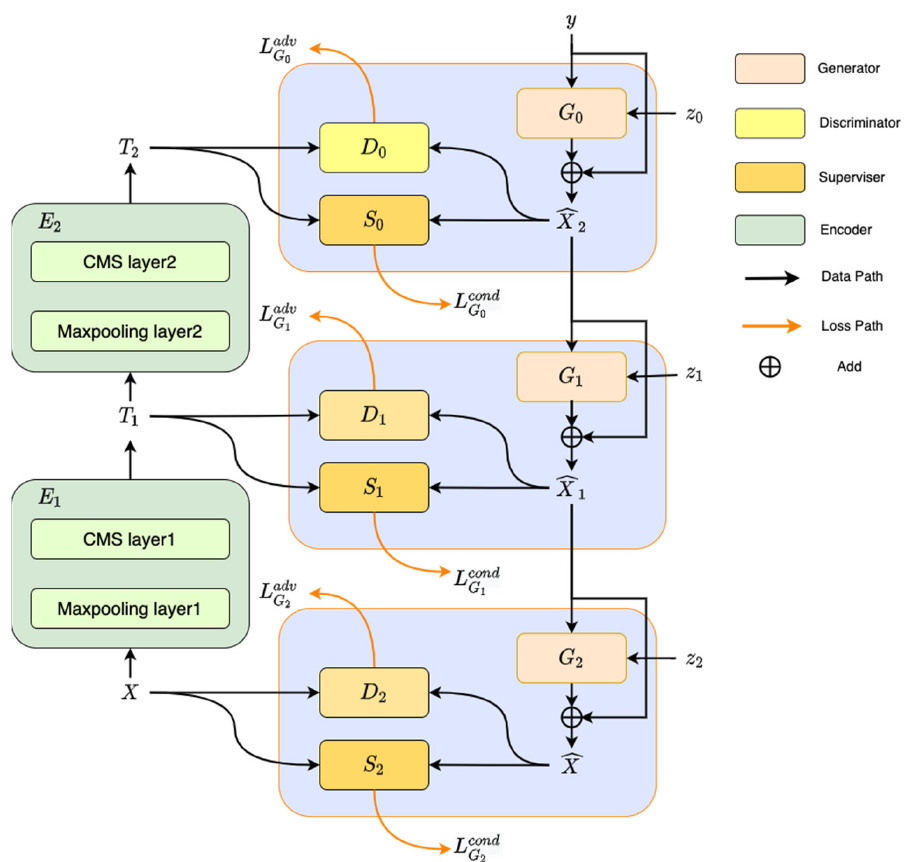
Figure 4. The structure of Stacked Siamese Generative Adversarial Network.